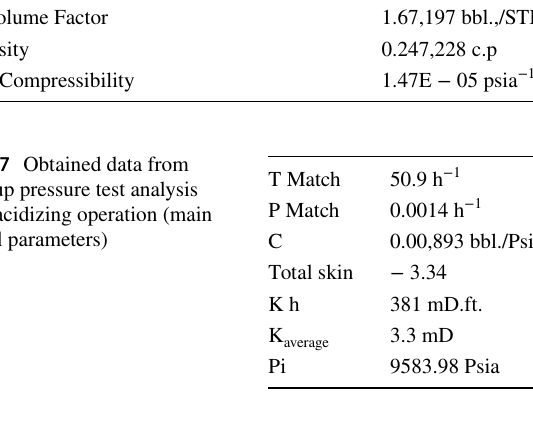
Table 8 Obtained data from buildup pressure test analysis after acidizing operation (reservoir and boundary parameters)